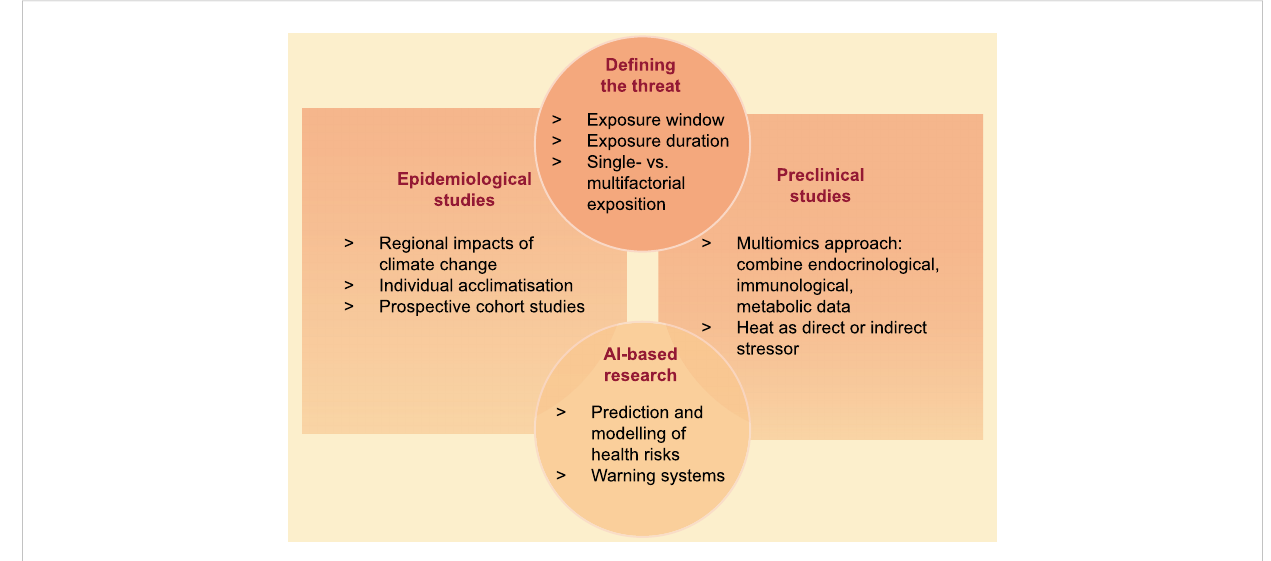
FIGURE 4 Future directions of heat stress related pregnancy